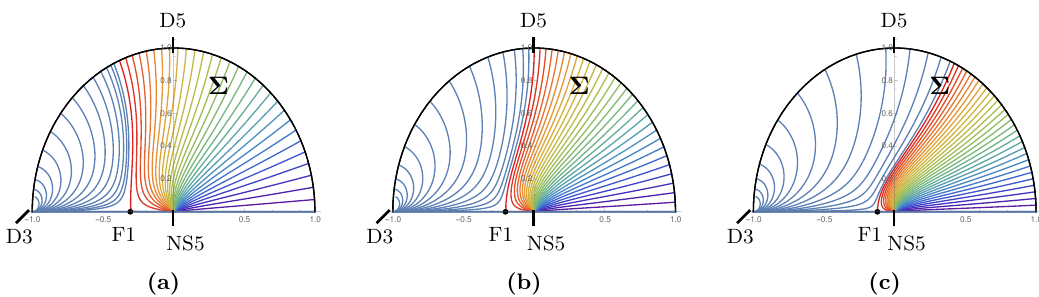
, 1 , 1 } . The D5/NS5 poles are 4 2